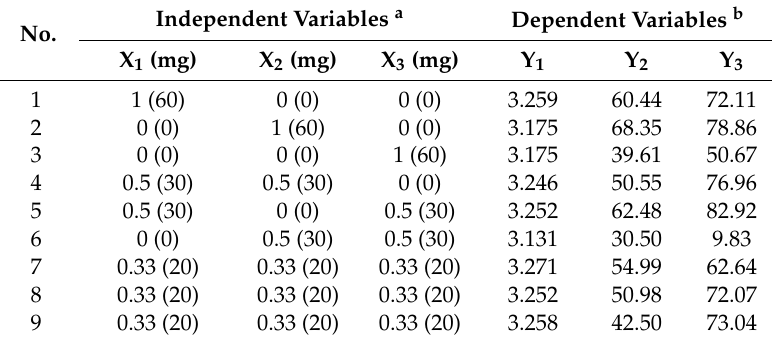
Table 2. Simplex-centroid mixture design and the resulting responses.